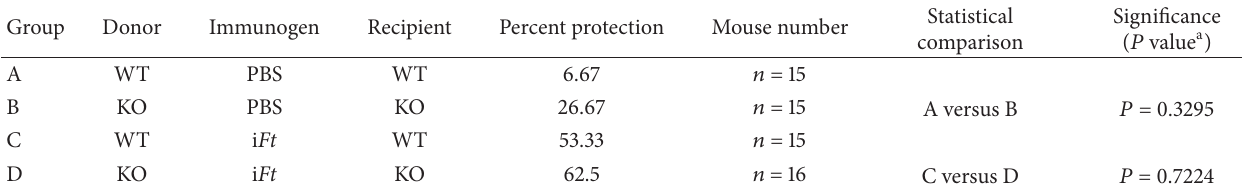
Table 2: Summary of adoptive transfer survival